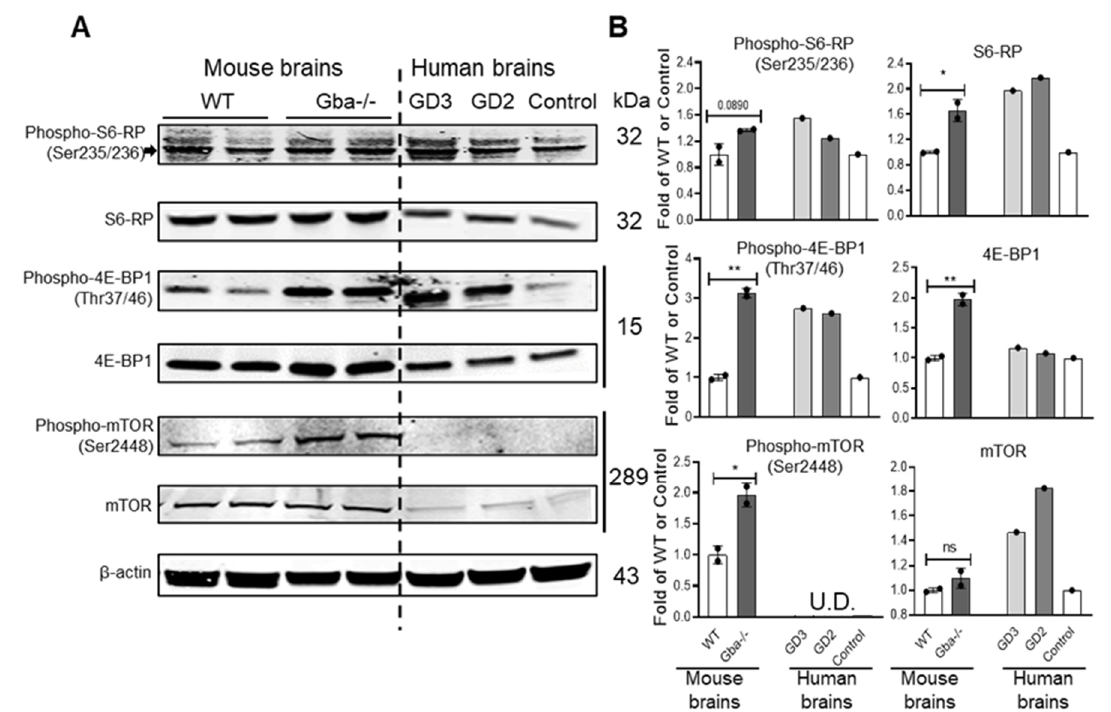
Figure 5. WB analysis of mTOR pathway proteins in mouse and human brains. ( A ) Protein was analyzed by WB. Gba -/-(NestinCre) mice brains (Gba -/- ) (29 days) were compared with WT mice (35 days). Human GD2 brain (15 months) and GD3 hippocampus (11.5 years) were compared with healthy control hippocampus (12 years). ( B ) Fold change of WT level after normalization by β -actin. Phospho-S6-RP (arrow)/S6-RP, phospho-4E-BP1/4E-BP1, and phospho-mTOR were increased in Gba -/-(NestinCre) mice brains compared with WT mice. Student’s t -test (replicate assays, n = 2 mice brains). In human samples, phospho-S6-RP/S6-RP, phospho-4E-BP1/4E-BP1, and mTOR were increased in GD2 brain and GD3 hippocampus compared with healthy control hippocampus. Phospho-mTOR was undetectable (U.D.) in human brains (replicate experiments, n = 1 human brain). Student’s t -test (* p < 0.05; ** p < 0.01). ns, not statistically significant.